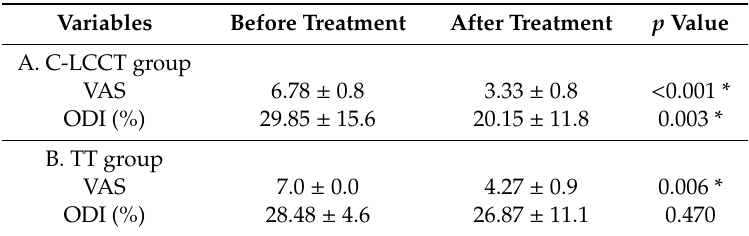
Table 2. Pain and functional scores in C-LCCT versus TT